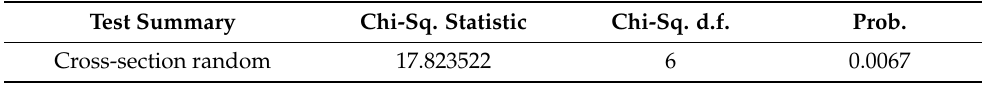
Table 7. Hausman test